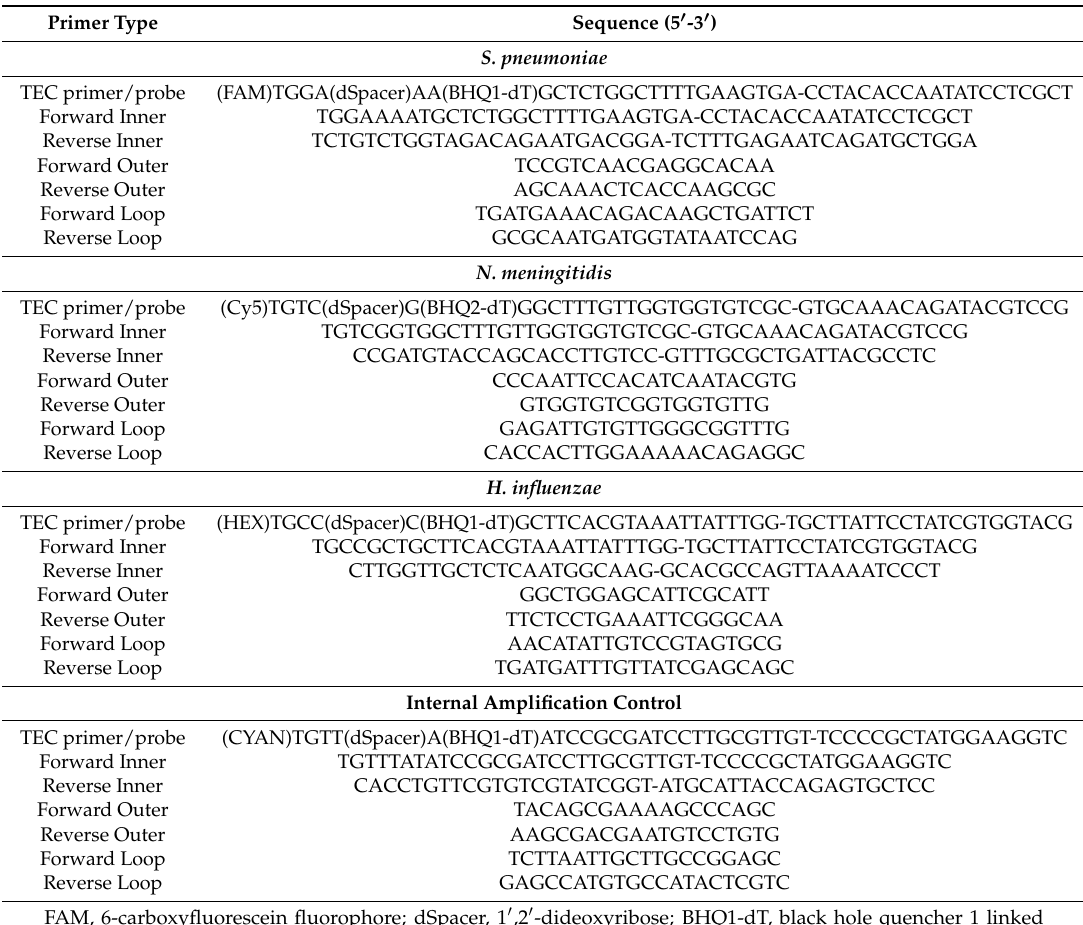
Table 1. TEC-LAMP